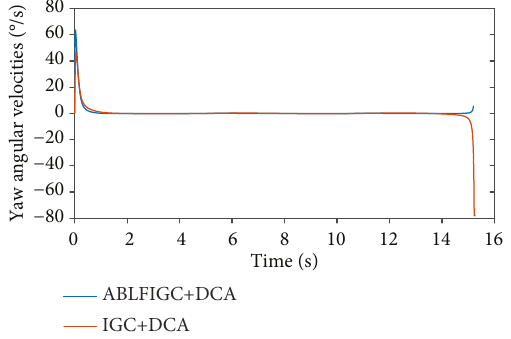
Figure 5: Sideslip angle curves of the interceptor missile in Scenario 1: ABLFIGC+DCA refers to a combination of the proposed asymmetric barrier Lyapunov function-based IGC algorithm and the dynamic control allocation algorithm; IGC+DCA refers to a combination of the IGC algorithm subject to the traditional dynamic surface sliding-mode control law and the dynamic control allocation algorithm. algorithm. As shown in these fi gures, the ABLFIGC+DCA algorithm rendered the actuator outputs bounded and